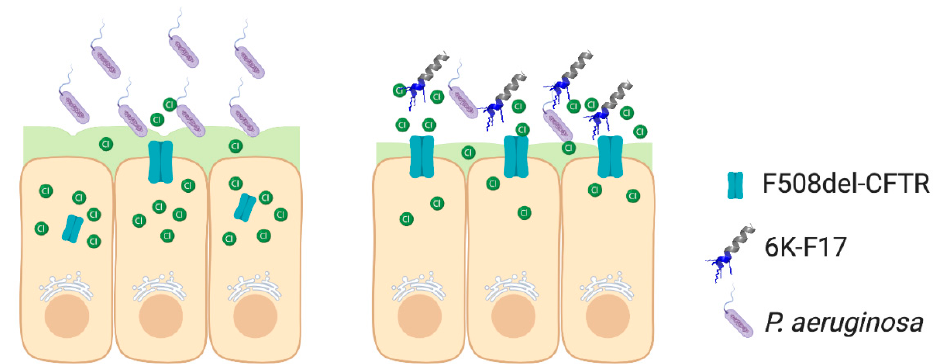
Figure 7. Schematic of P. aeruginosa infection of F508del-CFTR HBE cells. HBE cells are depicted in beige, with mucus on top of the apical membrane rendered in green. F508del-CFTR protein is shown in blue with Cl − ions as green circles. P aeruginosa bacteria are shown in purple with 6K-F17 peptide (sequence: KKKKKKAAFAAWAAFAA-amide) depicted as grey helices with blue positive charge on one terminus. Bacteria levels and mucus thickness decrease in 6K-F17 treated cells, as apical F508del-CFTR protein levels and Cl − flux increase.